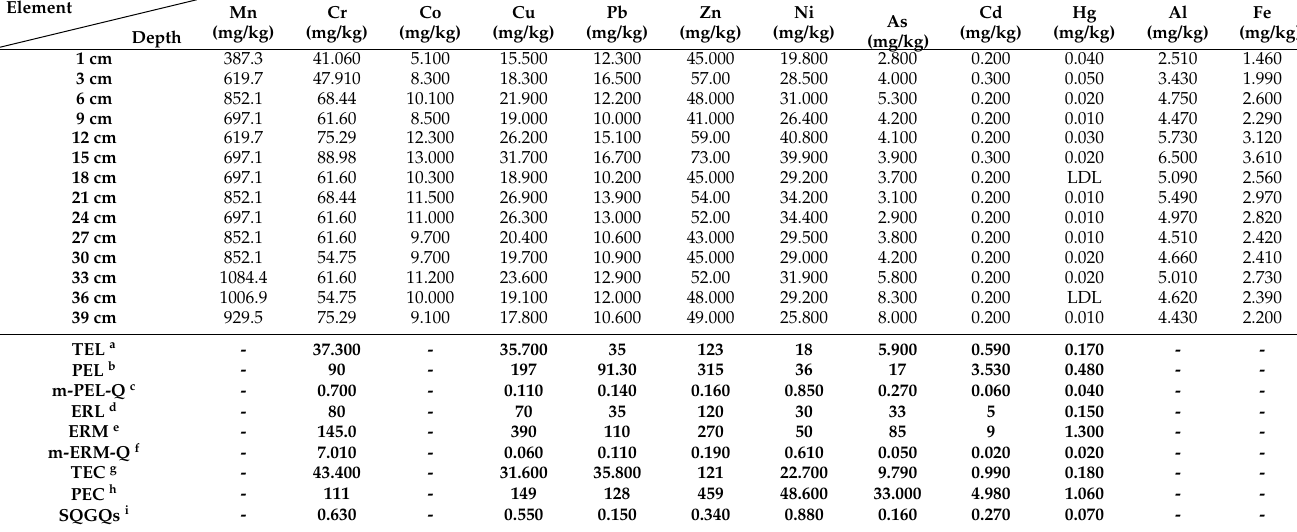
Table 2. Heavy metals content and values of SQGs, TEL, TEC, ERL, PEL, PEC and